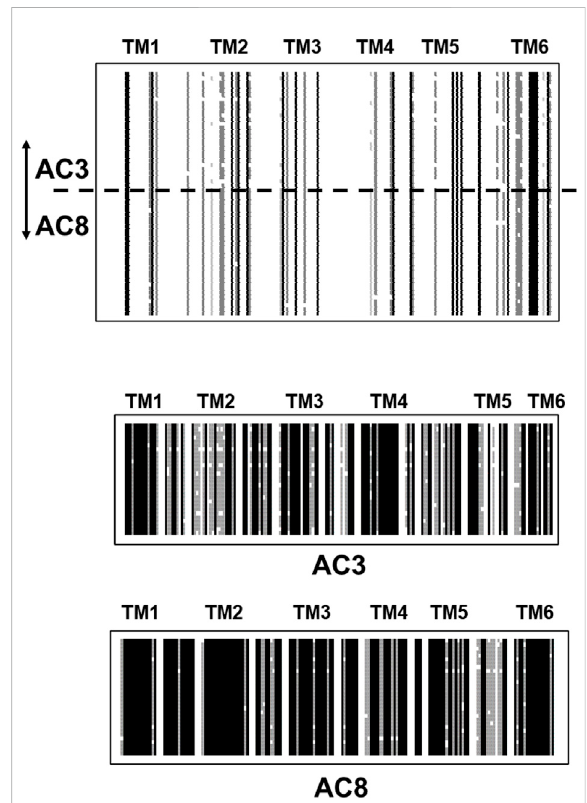
FIGURE 5 Top:Alignment ofthe fi rsthexahelicalmembranedomainsof mAC isoforms 3 (28 isoforms) and 8 (34 isoforms). The joint alignment shows scant conservation between the domains from mAC3 and 8. Single α -helices are indicated above the sequences. Below: alignments of the TM1 domains from mAC3 and mAC8. Note the high degree of conservation across a large variety of species. Shading: black, invariant; dark grey, conserved; light grey, slightly conserved; white: disparate. (Sequences used: AC3: Callithrix jacchus; alligator; antelope; ceratotherium simum simum; brown bat; chicken; chinchilla; desert mouse; dog; falcon; Mustela putorius furo; frog; goat; guinea pig; hog; horse; human; macaque; mouse; Heterocephalus; orca; coelacanth; rat; manatee; sheep; turtle; cat fi sh. AC8: myotis brandtii; Bos taurus;camel; cat; chicken; dog; Mustela putorius furo; frog; gibbon; guinea pig; hog; human; hedgehog; lemur; macaque; monkey; mouse; Heterocephalus; rhino; orca; baboon; Ochotona princeps; pigeon; rat; manatee; sheep; Melopsittacus undulatus; squirrel; vicuna;